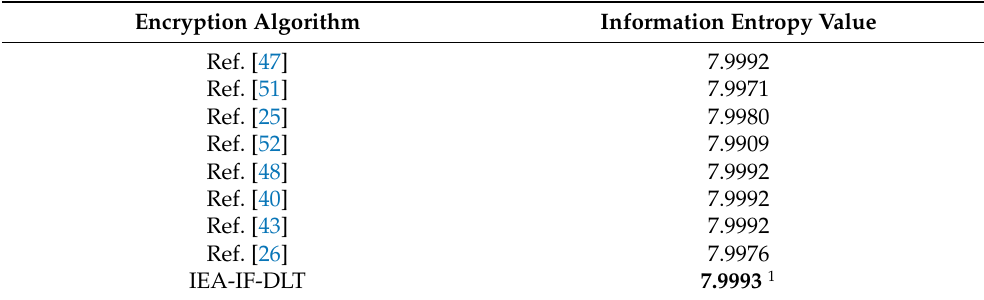
Table 7. Information entropy values of Lena cipher images generated by different image encryp- tion